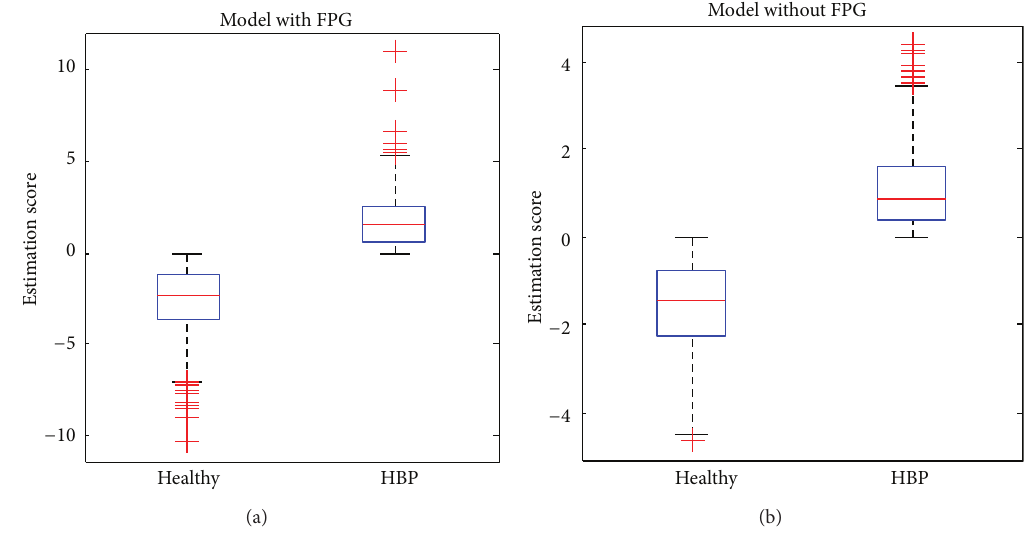
Figure 3: Box plots of the distribution of estimation scores for the healthy and HBP groups. (a) Model with FPG and (b) model without FPG.